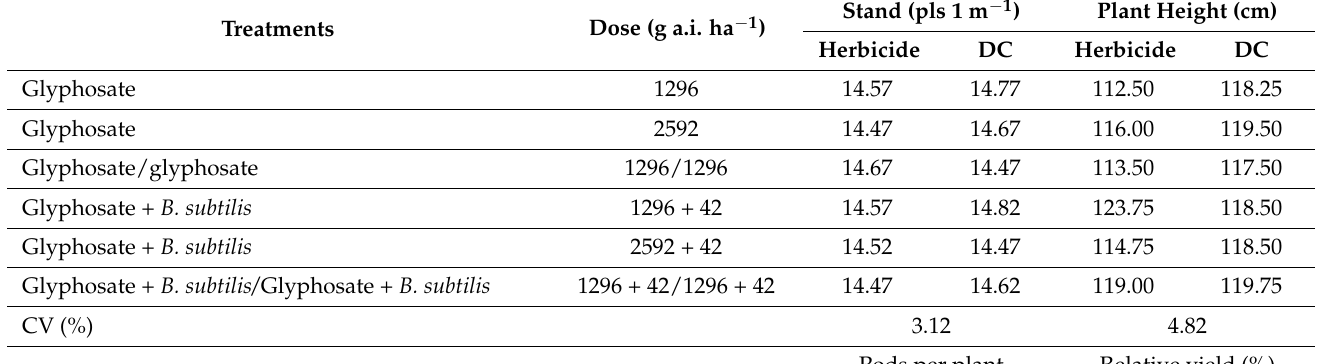
Table 4. Stand, plant height, number of pods, and soybean yield after post-emergence application of glyphosate at different doses and stages and the association with B. subtilis BV02. Treatments